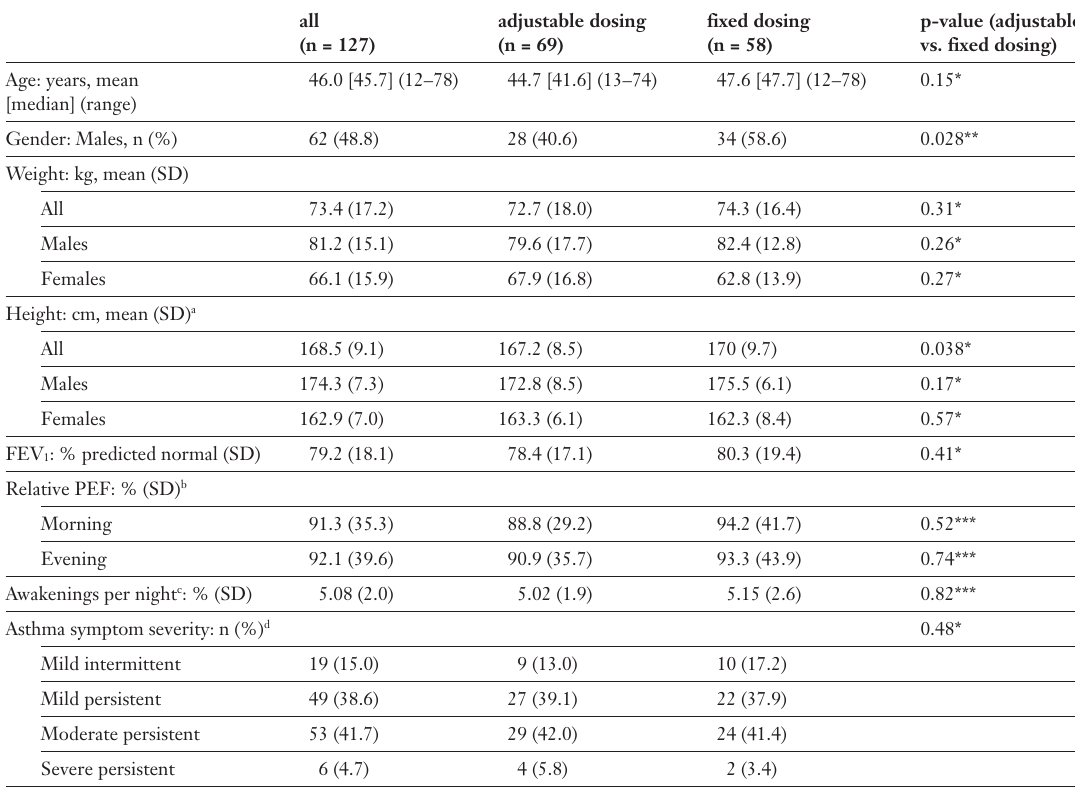
Table 1 Demographic and baseline characteristics.